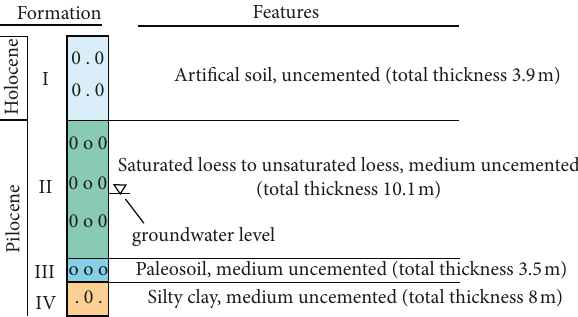
Figure 2: Stratigraphic map of the tunnel construction